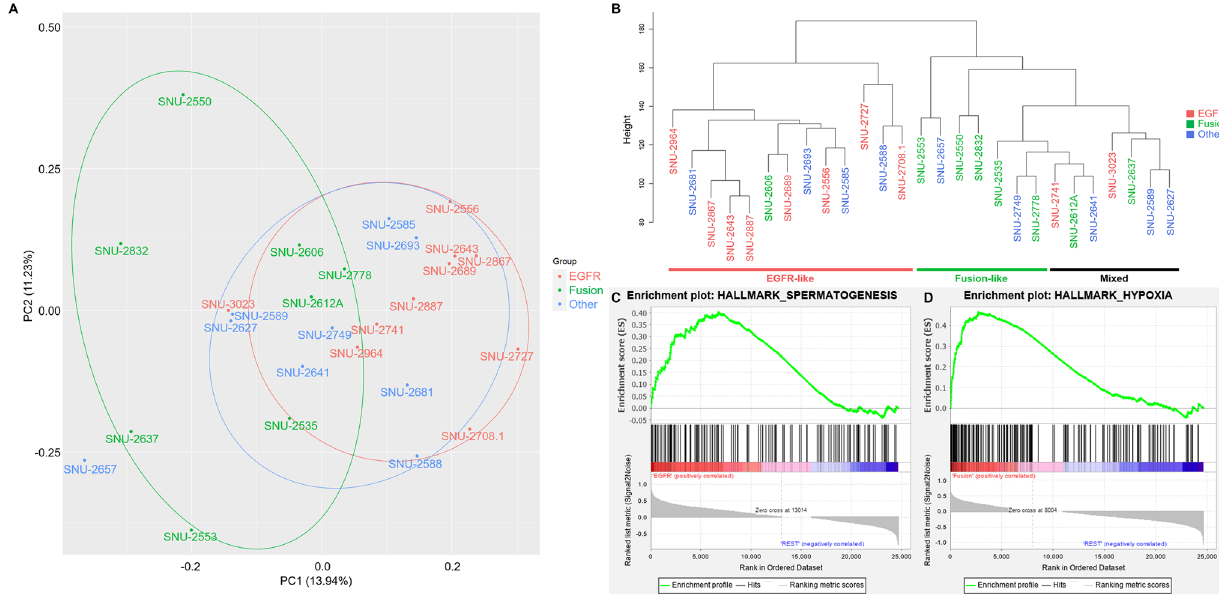
Figure 3. EGFR and fusion subtypes are separated in transcriptomic patterns. ( A ) Principle component analysis indicated that MPE-derived cell lines with fusion events exhibited higher transcriptional heterogeneity than EGFR -mutant types. The principle component 1 and 2 accounted for 13.94% and 11.23% of the total loading components respectively. Each group is marked with representative colors. ( B) Hierarchal clustering analysis demonstrated there are characteristic expressional patterns between EGFR -mutant and fusion gene groups. Cell lines with mutated genes other than the EGFR and fusion gene are not clustered. Each groups are marked with representative colors. ( C) See also Supplementary Table 4. GSEA analysis revealed that spermatogenesis pathway is upregulated in EGFR-mutant groups compared to the other cell lines. ( D) See also Supplementary Table 4. Hypoxia pathway is distinctively expressed in fusion gene group. The statistical settings for GSEA analysis is as follows (Number of permutations = 1000, Permutation type = phenotype, Chip platform = MSigDB.v.7.4.chip, Enrichment statistic = weighted, Max size: exclude larger sets = 500, Min size: exclude smaller sets =